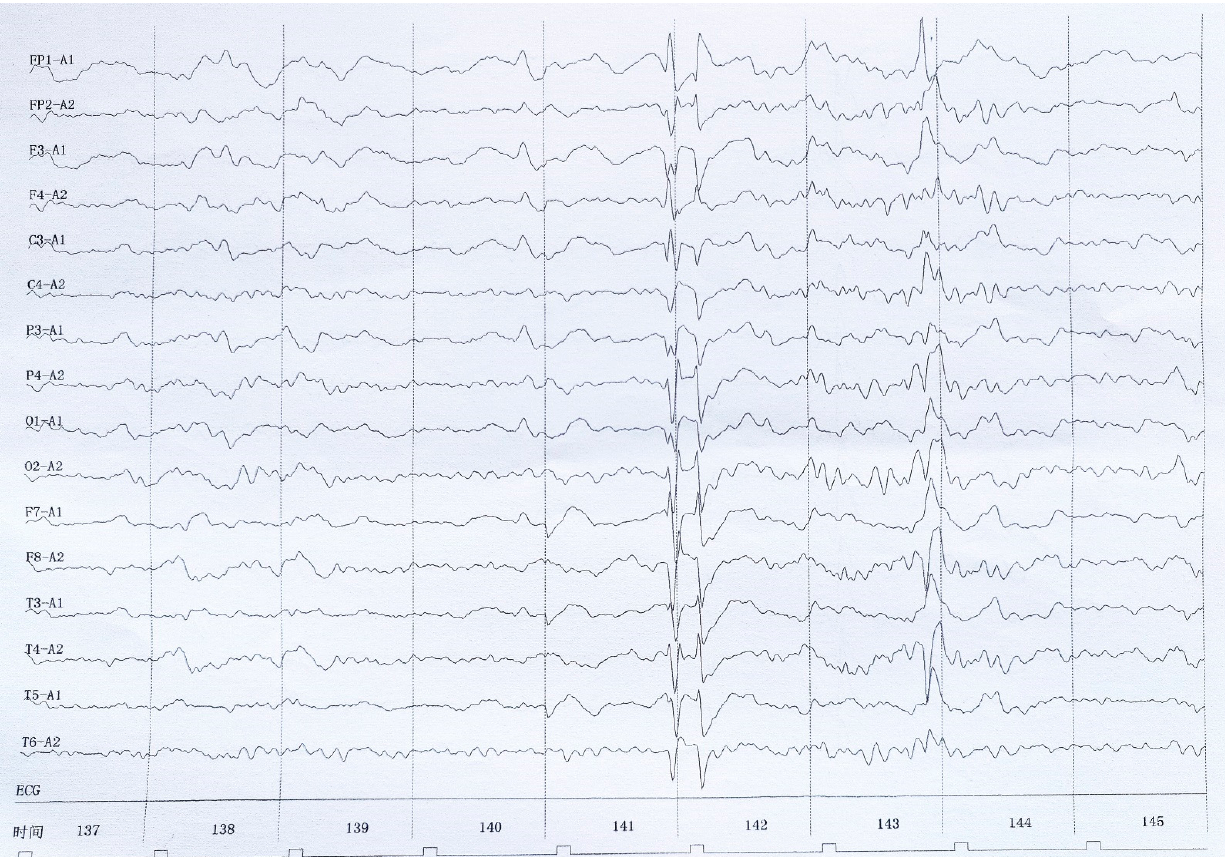
Figure 1. EEG showing the main rhythmic activities (low-amplitude α wave, irregular waveform, scattered sharp wave, and sharp–slow wave). The visual response did not significantly change (100 µ/cm and 30 mm/s).